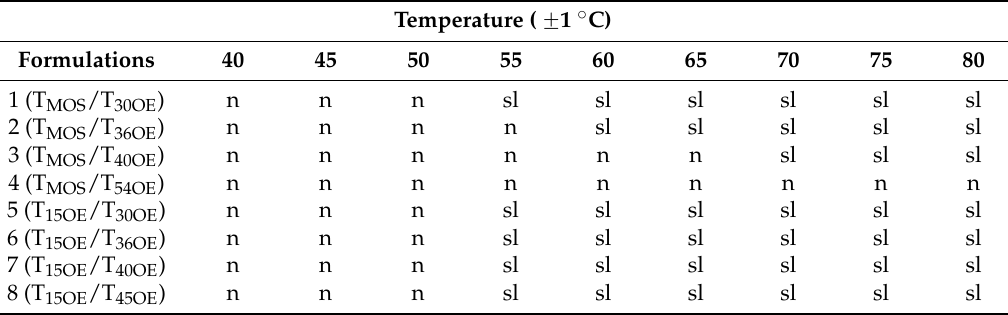
Table 3. Nanoemulsion stability according different temperature values.